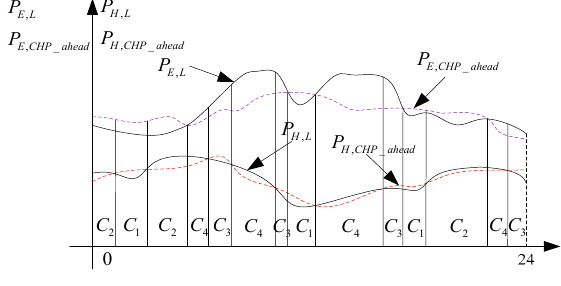
Figure 5. Operation modes identification for CHP.